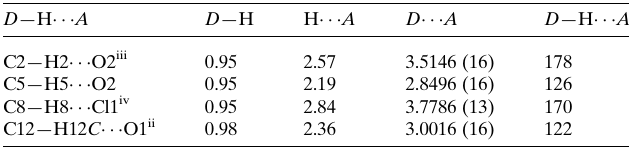
Table 1 Hydrogen-bond geometry (A˚ , (cid:2) ).